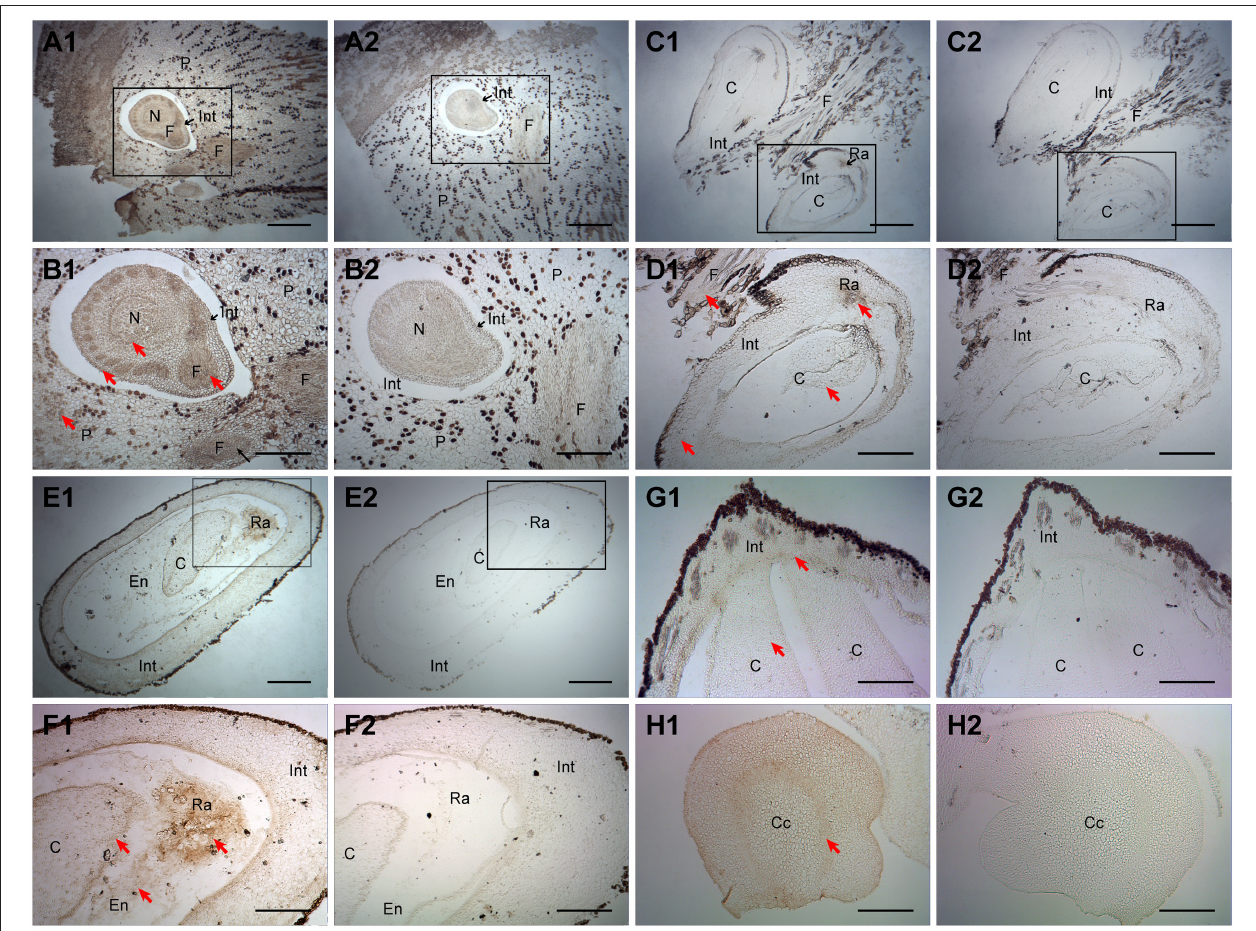
FIGURE 4 | Immunohistochemical analysis of ChARF3 localization during ovule development. (A1, A2, B1, and B2) Before fertilization at stage Ov1.1, the ChARF3 staining of funiculus, integument, and parenchyma is deeper, 40 days after blooming. B1 and B2 are enlarged views of black squares in A1 and A2, respectively. (C1, C2, D1, and D2) After fertilization at stage Ov2.1, the ChARF3 staining of funiculus, integument, radicle, and cotyledon is obvious, 70 days after blooming. D1 and D2 are enlarged views of black squares in C1 and C2, respectively. (E1, E2, F1, and F2) During growth of the ovule at stage Ov3.1, the ChARF3 staining is enriched in the cotyledon, endosperm, and radicle, 100 days after blooming. F1 and F2 are enlarged views of black squares in E1 and E2, respectively. (G1, G2, H1, and H2) The ChARF3 staining keep higher in the cotyledon and radicle, 100 days after blooming. (A2–H2) The control of A1 to H1 without secondary antibody treatment, respectively. Key: Cc: central cylinder; C: cotyledon; En: endosperm; F, funiculus; Int, integument; N, nucellus; P, parenchyma; Ra: radicle; St, style. Scale bars: A, C, E = 400 µ m; B, D, F, G, H = 200 µ m. Positive staining is shown in brown. Red arrows indicate the localized